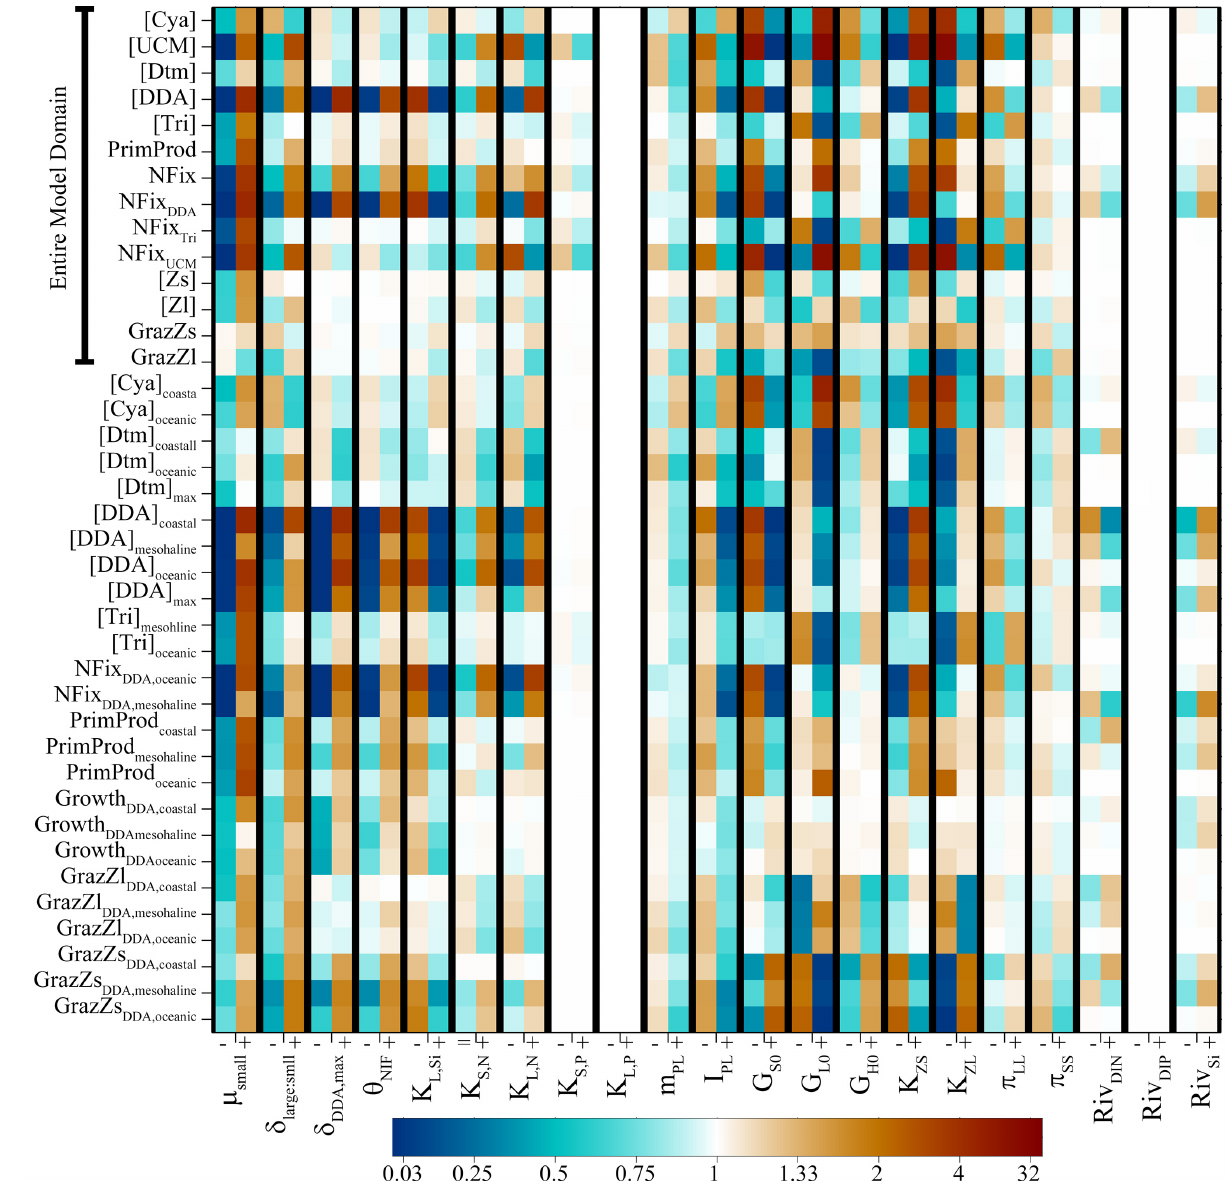
Figure 9. Sensitivity Analysis. Relationship of important model outputs (rates and standing stocks, y axis) to variations in key model parameters ( x axis). For each parameter, two four month simulations were conducted in which the parameter was either halved or doubled. Color axis shows the relationship of each model output at the end of the four month simulation to the equivalent model output in the DIAZO base model run. For instance, a result of 2 corresponds to a doubling relative to the DIAZO base model run standing stock or rate. First 14 outputs are averaged over the entire basin. The rest are restricted to the ARP region. Parameters varied were µ small (which varies the growth rate of all phytoplankton proportionally, Eq. 19), δ large : small (difference in growth between diatoms and cyanos, Eq. 19), δ DDA : Dtm (difference in growth between DDAs and diatoms, Eq. 20), θ NIF (DDA NFix penalty, Eq. 21), K L , Si (Diatom half-saturation constant for Si, Eqs. 6 and 8), K S , N (Cyano half-saturation constant for DIN, Eq. 2), K L , N (Diatom half-saturation constant for DIN, Eq. 6), K S,P (Cyano half-saturation constant for DIP, Eqs. 2 and 4), K L,P (Diatom half-saturation constant for DIP, Eqs. 6 and 8), m PL (Diatom intrinsic mortality, Eqs. 5 and 7), I PL (Diatom growth-irradiance parameter, Eqs. 6 and 8), G S0 (Protozoan max grazing rate, Eq. 13), G L0 (Mesozooplankton max grazing rate, Eq. 17), G H0 (Higher predator max grazing rate, Eq. 15), K ZS (Protozoan half-saturation constant, Eq. 13), K ZL (Mesozooplankton half-saturation constant, Eq. 17), π LL (Mesozooplankton preference for diatoms, Eq. 18), π SS (Protozoan preference for cyanos, Eq. 14), Riv DIN (riverine DIN concentration), Riv DIP (riverine DIP concentration), Riv Si (riverine Si